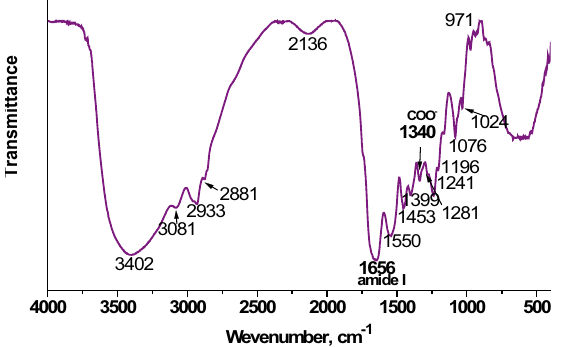
Figure 3. FTIR spectrum of pure collagen